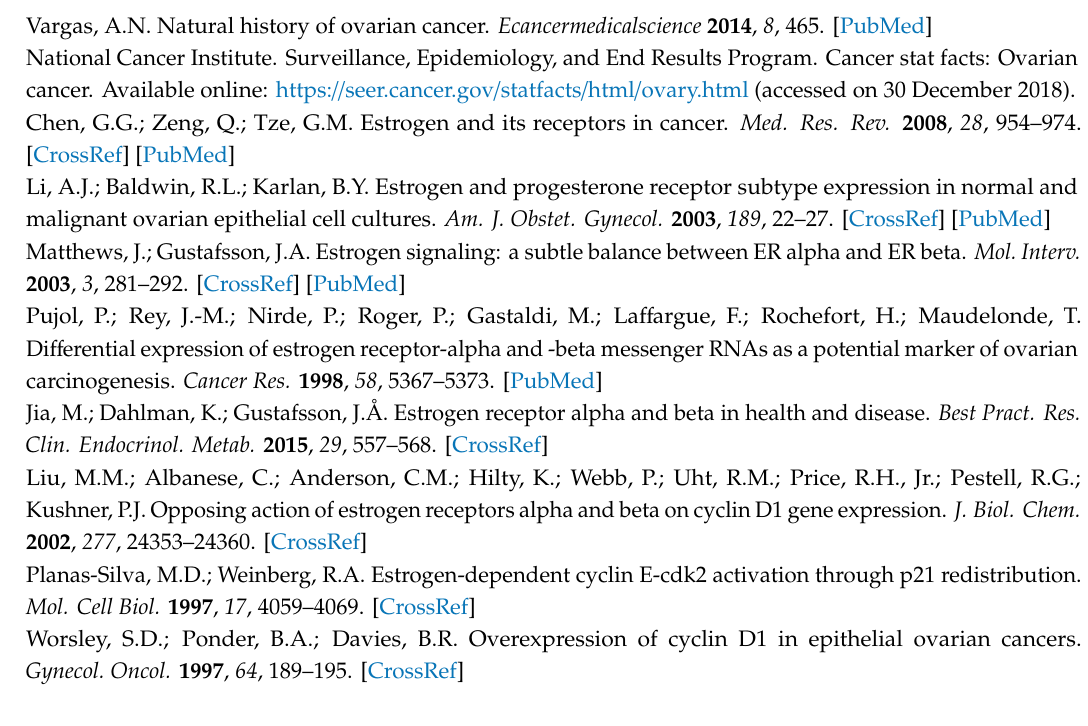
Supplementary Materials: Supplementary LC-ESI-MS and MALDI TOF material, list of primers for quantitative